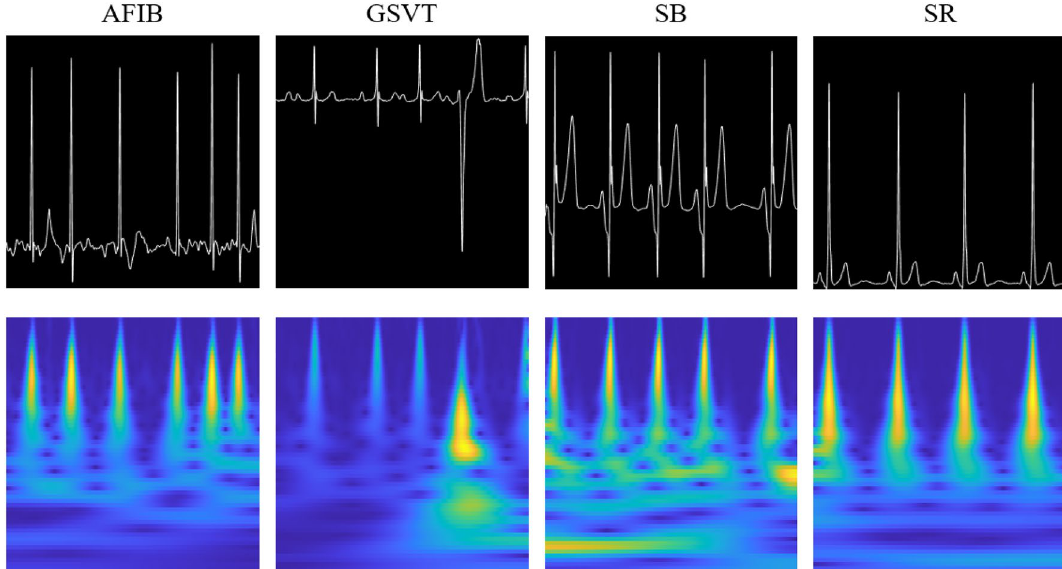
Figure 1. Sample images of grayscale images and scalograms for the four groups of ECG recordings (AFIB, GSVT, SB, and SR). Each column represents the AFIB, GSVT, SB, and SR classes. The first row is grayscale images of the ECG signals, and the second row is scalograms of the ECG signals.